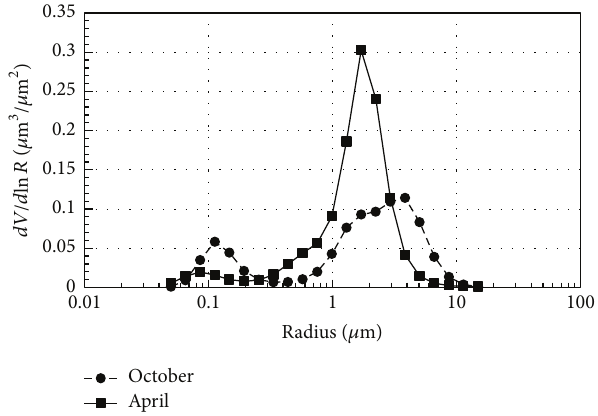
Figure 12: Size distribution of AERONET station at Solar Village in April 2012 and October